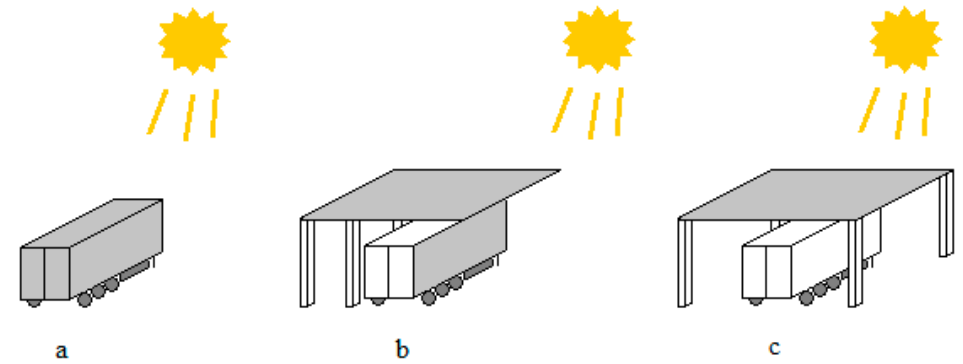
Figure 3. Location of the refrigerated semi-trailer, where ( a ) semi-trailer is parked without roofing, influenced by insolation, ( b ) semi-trailer is parked under a shed, with the sun reaching one side wall of the semi-trailer, and ( c ) semi-trailer is parked under a shed that eliminates the influence of insolation.